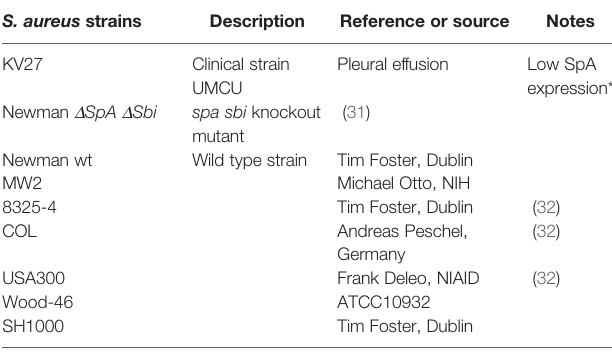
TABLE 1 | S. aureus strains